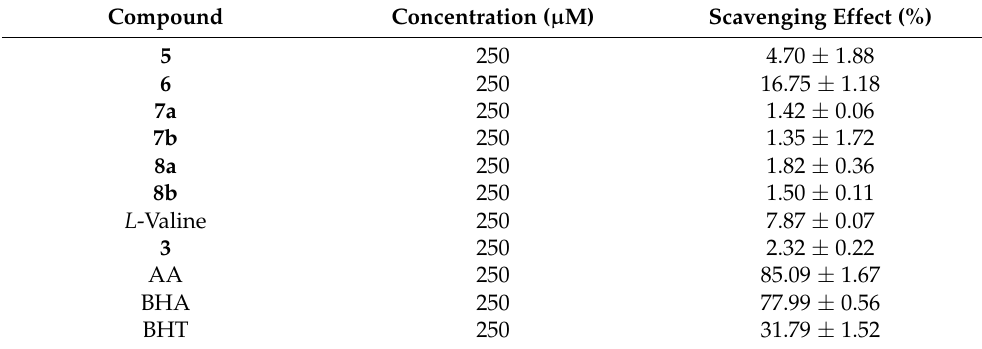
Table 6. Results of the assessment of the antioxidant effect of the compounds tested by the DPPH method.